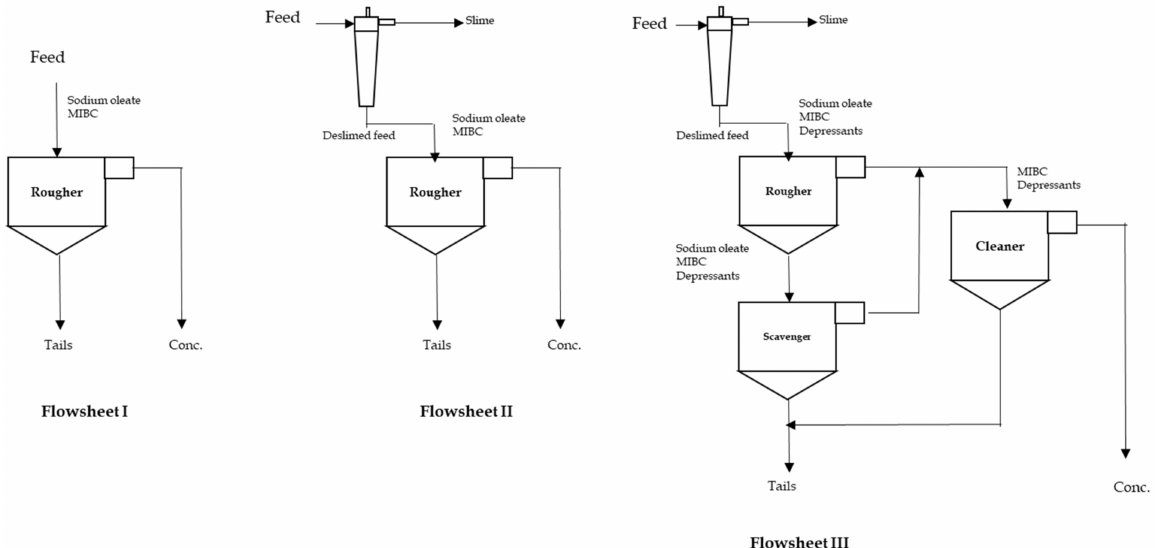
Figure 1. Schematic representation of the flotation flowsheets used in this study.